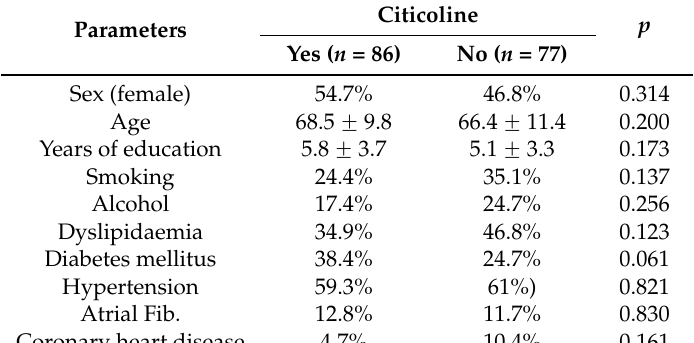
Table 1. Baseline characteristics in patients who received and did not received citicoline.